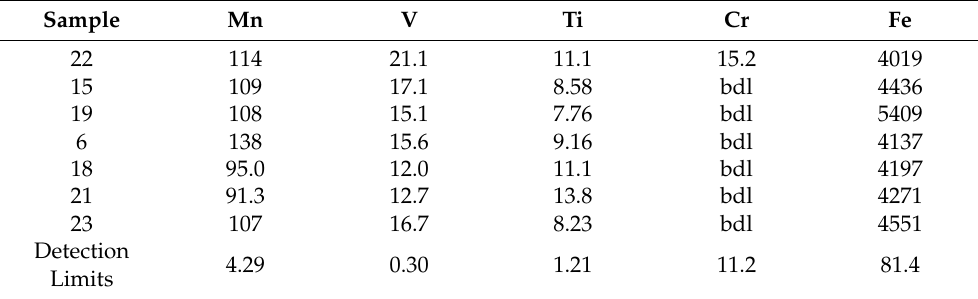
Table 2. Contents of trace elements in samples with green fluorescence under LWUV